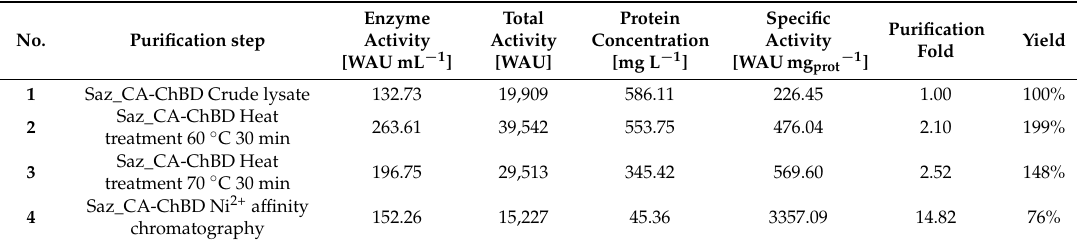
Table 2. Protein purification results of